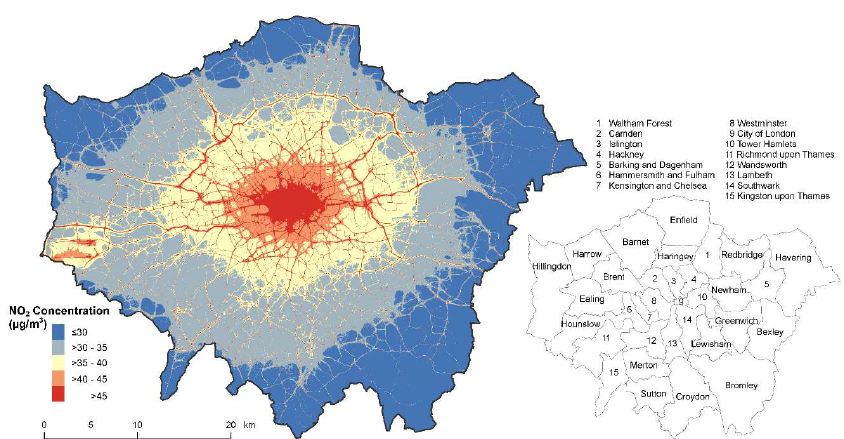
Figure 2. Annual average NO 2 concentrations in Greater London from the London Atmospheric Emissions Inventory 2016, 20 m resolution and London Boroughs [Contains public sector information licensed under the Open Government Licence